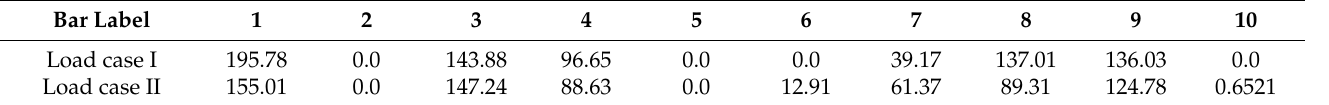
Table 10. Cross-sectional area (cm 2 ) of the bars in the optimal trusses in experiment